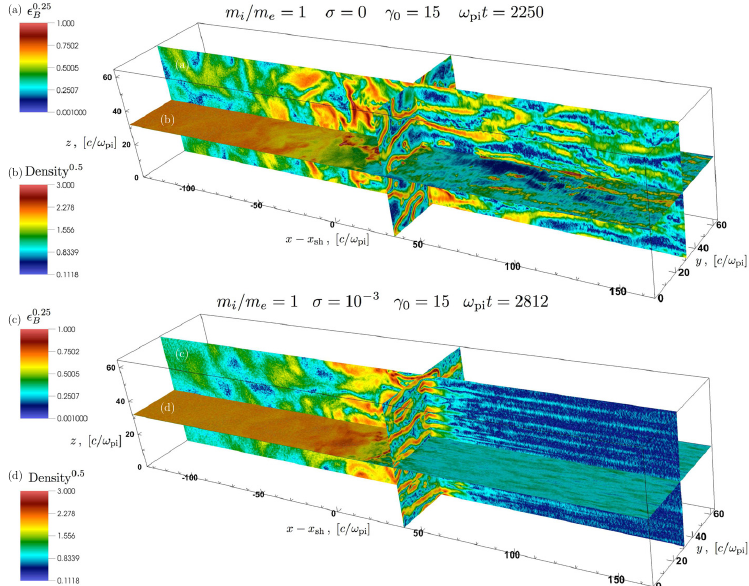
Figure5. Structureoftheflow,fromthe3Dsimulationofanelectron–positronshockwithmagnetization σ = 0(top)or σ = 10 − 3 (bottom).The xy sliceshowsthe particledensity(withcolorscalestretchedforclarity),whereasthe xz and yz slicesshowthemagneticenergyfraction (cid:9) B (withcolorscalestretchedforclarity). (Acolorversionofthisfigureisavailableintheonlinejournal.) Figure 2. Structure of the flow, from the 3D simulation of an electron-positron shock with magnetization σ = 0 ( top ) or σ = 10 − 3 ( bottom ). Panels ( b ) and ( d ) show the particle density in the xy slice (with color scale stretched for clarity), whereas Panels ( a ) and ( c )show the the magnetic energy fraction (cid:101) B in the xz and yz slices (with color scale stretched for clarity). Adapted from Figure 5 in